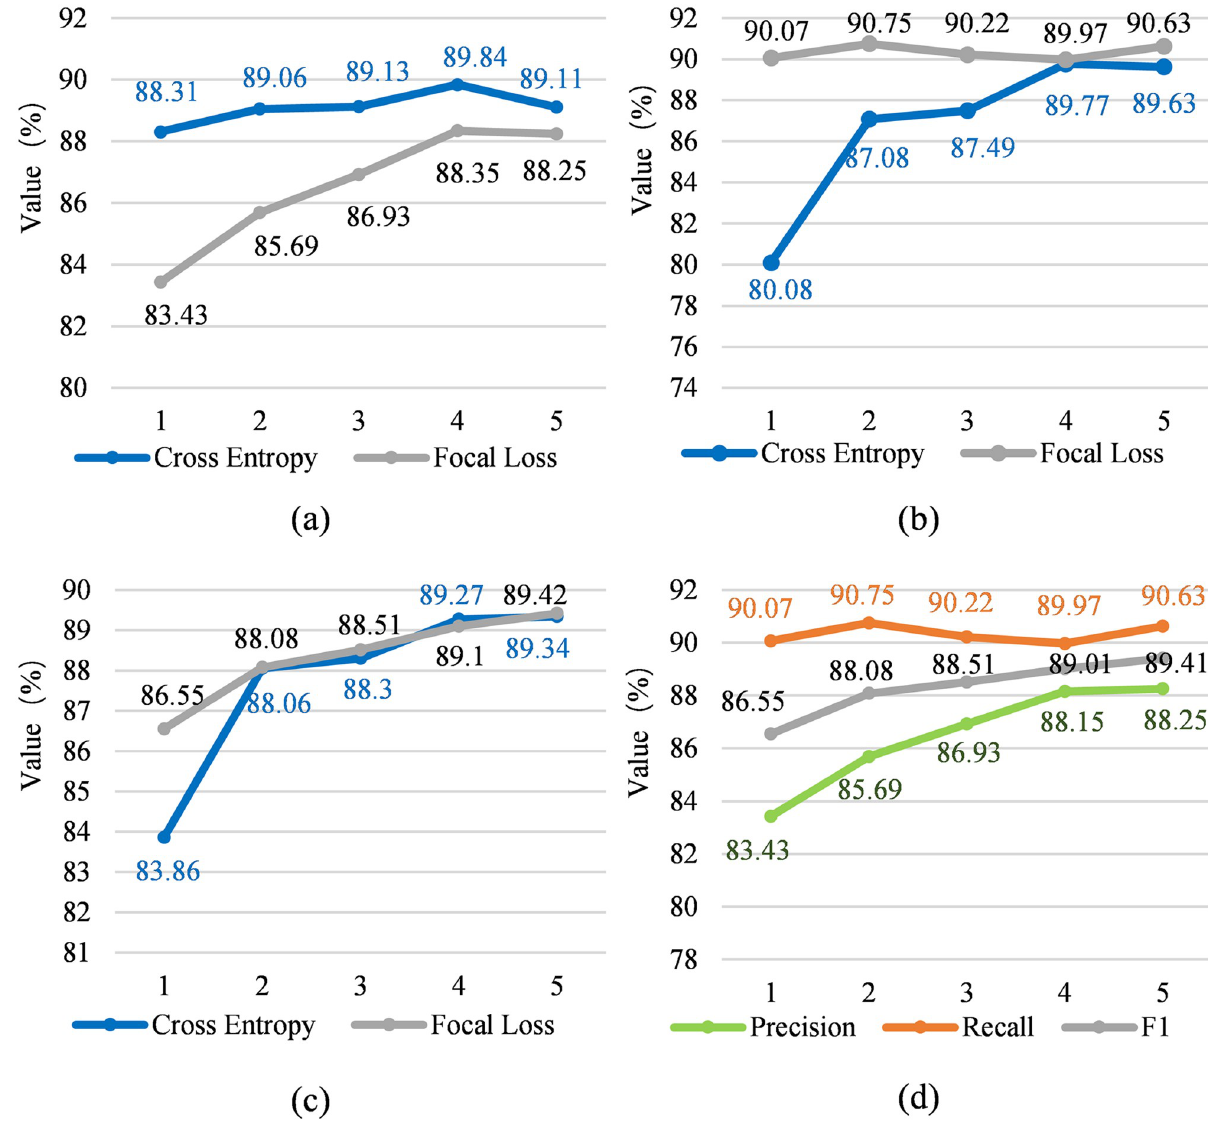
Fig 4. Precision, recall and F1 rate of focal loss